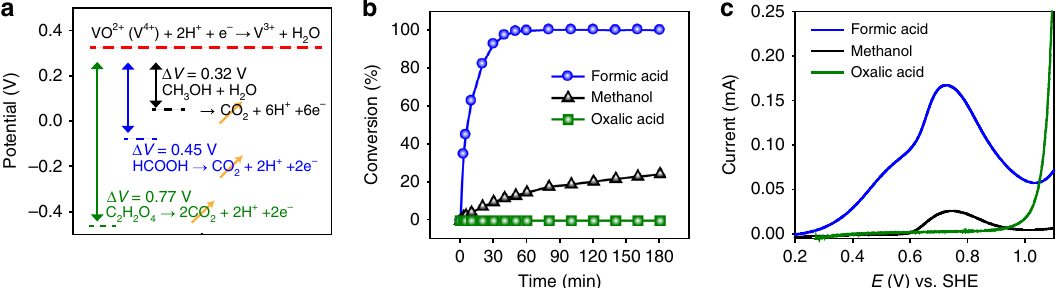
Fig. 3 Effect of reducing agent on the catalytic reduction. a Standard redox potentials for the redox reactions of the reducing agents and that of the V 4 + /V 3 + redox couple. b Conversion of the V 4 + electrolyte by formic acid, oxalic acid, and methanol. c Linear sweep voltammetry (LSV) results for oxidation of the reducing agents on the Pt/C-deposited rotating disk